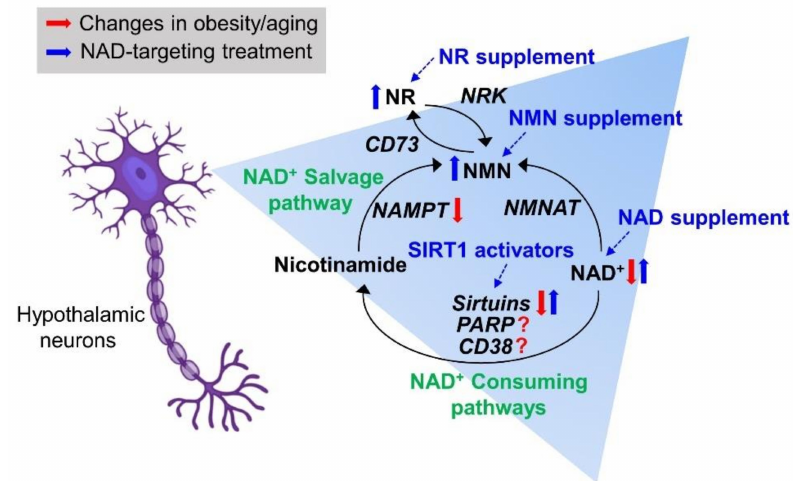
Figure 2. NAD + biology-targeting treatment strategies for obesity- and aging-related metabolic and circadian disorders. CD38: cyclic ADP-ribose cyclase / cluster of di ff erentiation 38, CD73: ecto-5 (cid:48) -nucleotidase / cluster of di ff erentiation 73, NAD + : nicotinamide adenine dinucleotide, NAMPT, nicotinamide phosphoribosyltransferase, NMN, nicotinamide mononucleotide, NMNAT: nicotinamide mononucleotide adenylyltransferase, NR: nicotinamide riboside, NRK: nicotinamide riboside kinase, and PARP: poly(ADP-ribose)